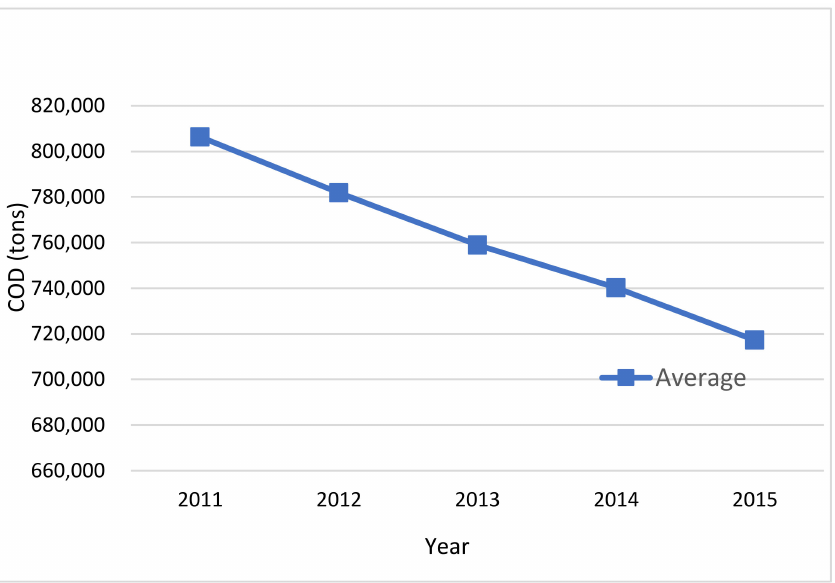
Figure 6. Average COD over 2011–2015 in